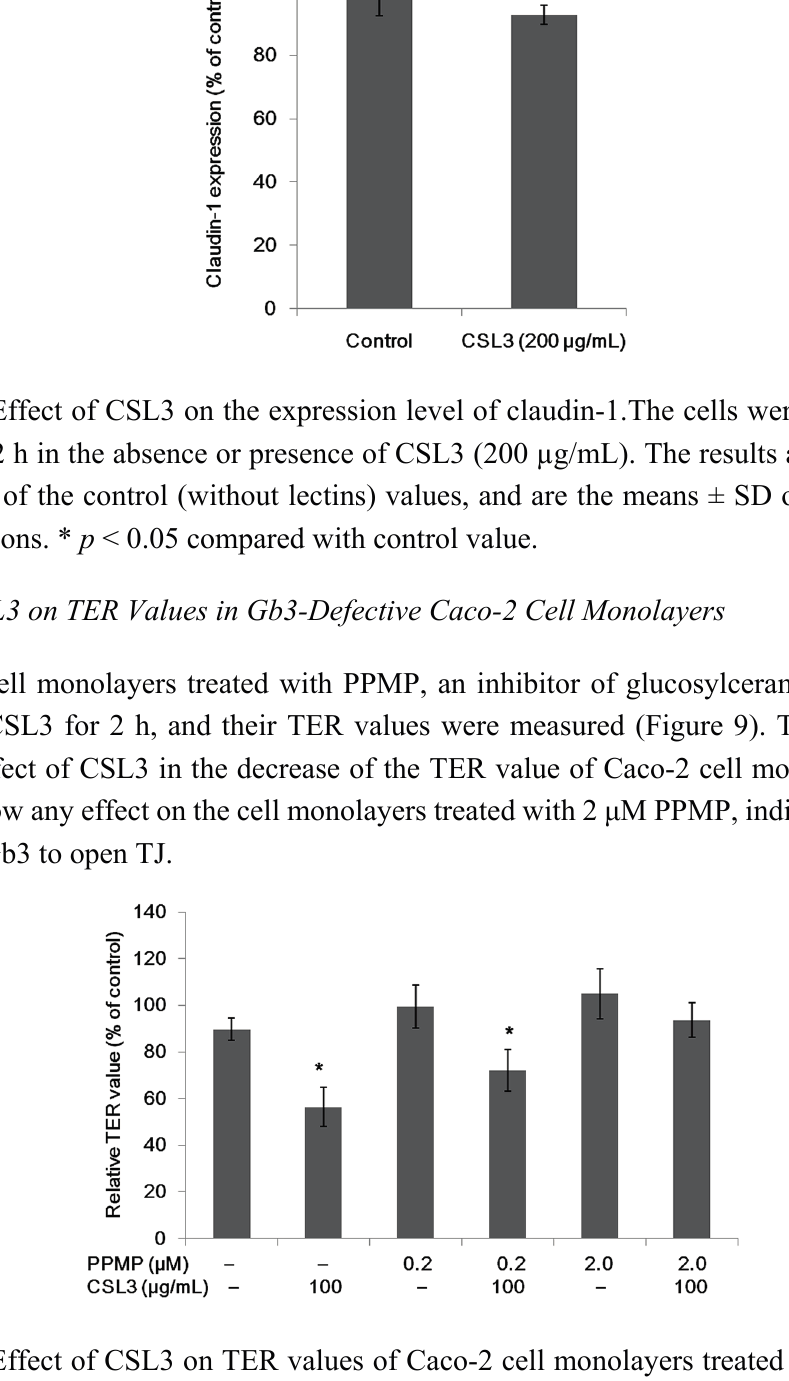
Figure 9. Effect of CSL3 on TER values of Caco-2 cell monolayers treated with PPMP to suppress the Gb3 expression. The TER values of the monolayers were measured after incubating with CSL3 (100 µg/mL) for 2 h. Results are shown as the percentage of the control (without PPMP and CSL3) values, and are the means ± SD of three different determinations. * p < 0.05 compared with the control